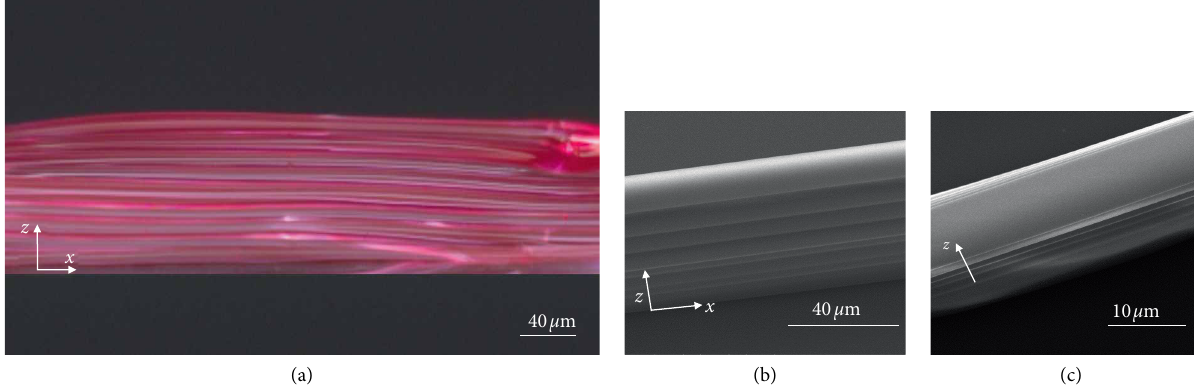
Figure 3: (a) Free standing single wall, (b–c) SEM image of the multi-layered wall with two different angle of